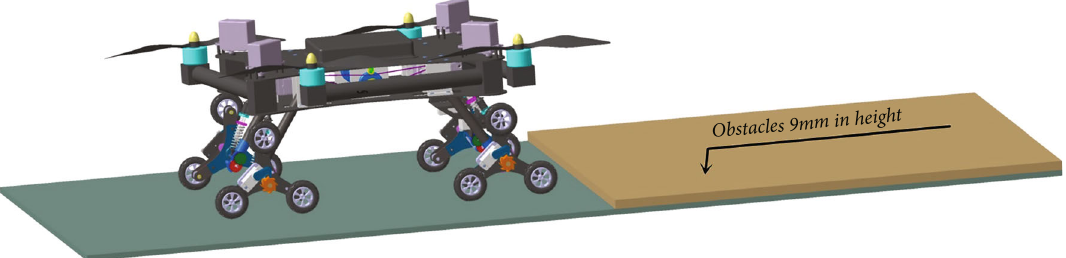
Figure 7: Simulation model of two planetary wheels over the steps at the same